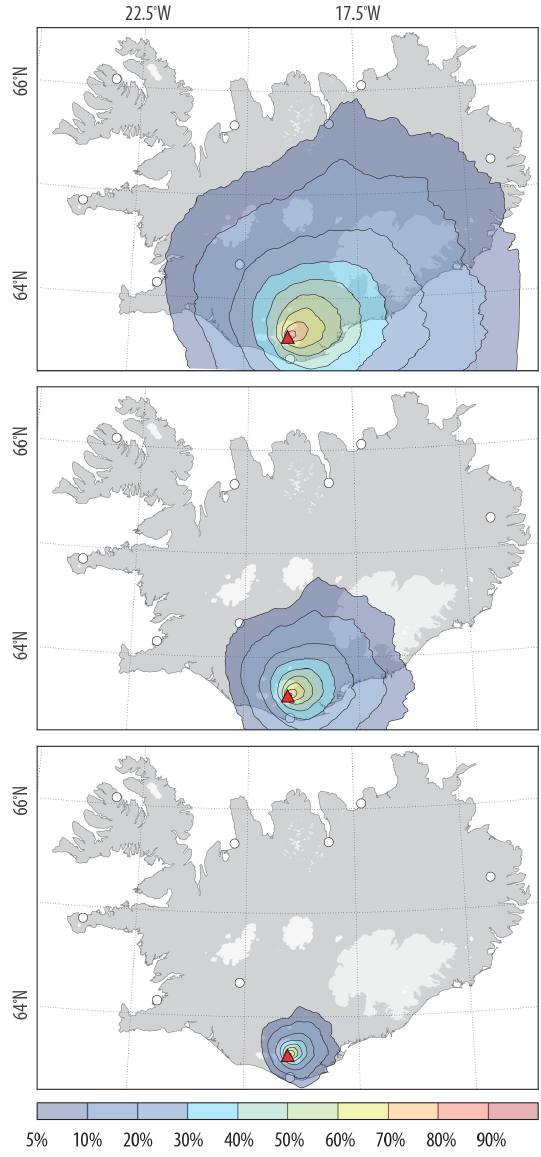
Figure 9. Probability maps (%) for ground accumulation for a long- lasting eruption at Katla. (a) LLERS, threshold of 1kgm − 2 ; (b) LLERS, threshold of 10kgm − 2 ; (c) LLERS, threshold of 100kgm − 2 . Eruption parameters are summarized in Table 3 and Fig.